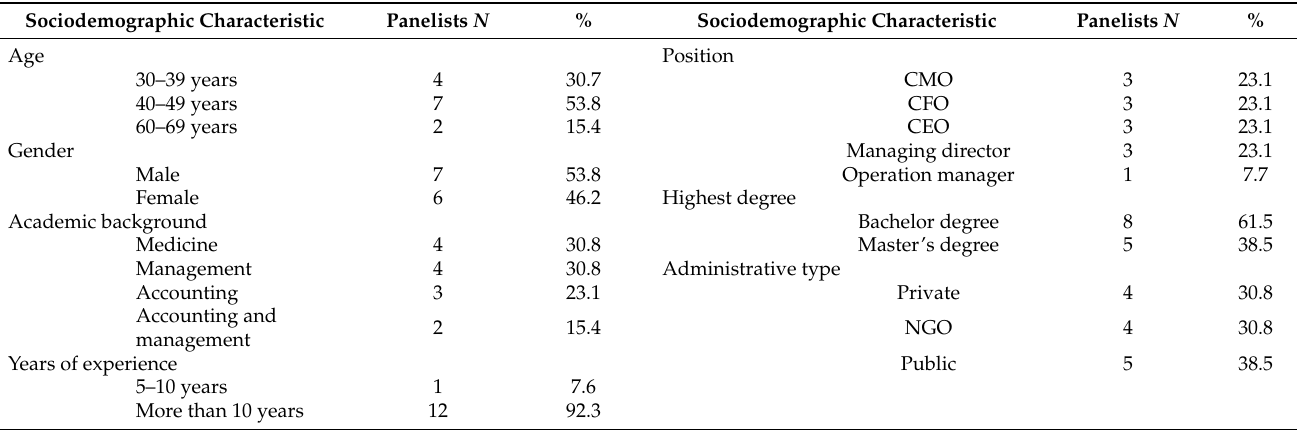
Table 1. Sociodemographic and characteristics of the second panel (executive